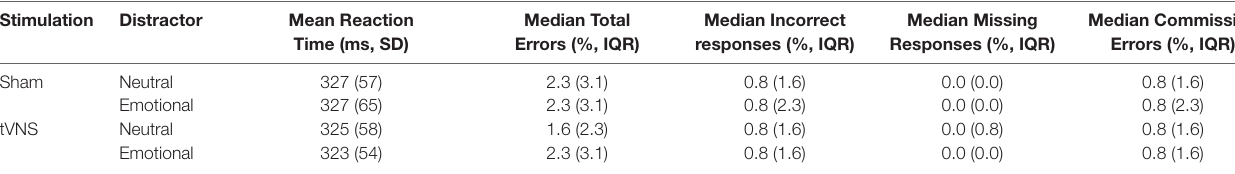
TABLE 1 | Behavioral results of the Executive Reaction time test.